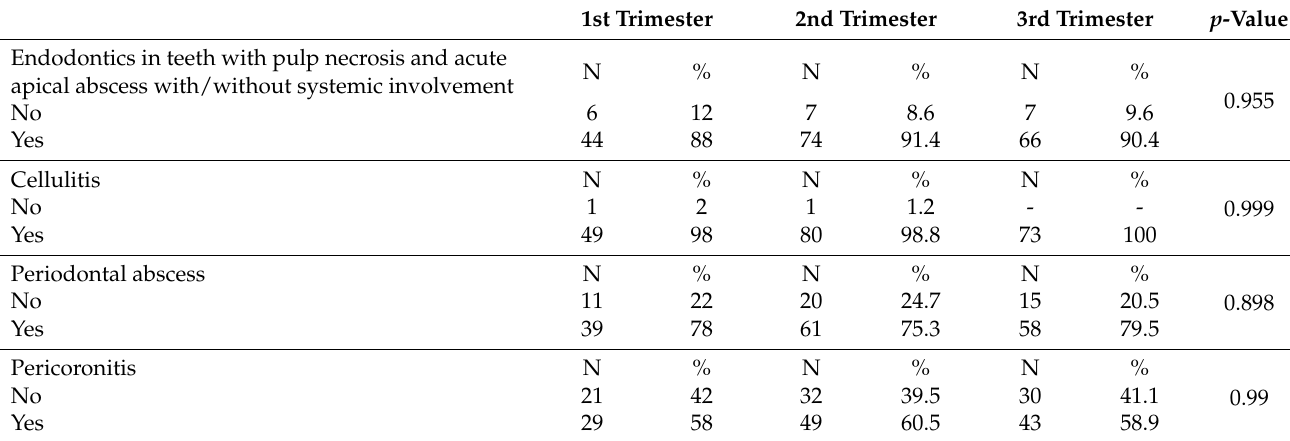
Table 6. Percentage of dentists who prescribed antibiotics according to trimester of pregnancy in pathologies that most frequently cause systemic